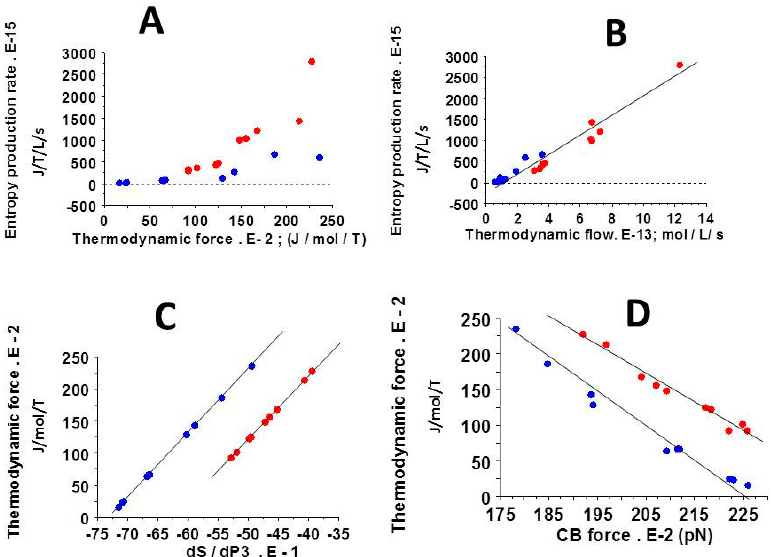
Figure 5. Parameters of statistical mechanics. ( A ): Non-linear relationship between the entropy production rate and the thermodynamic force. Influence of the thermodynamic force was moderately greater in COL-MSC-RDG (red) scaffolds than in COL-MSC scaffolds (blue); ( B ): Linear relationship between the entropy production rate and the thermodynamic flow; y = -212 + 216 * x; r =0.97. Influence of the thermodynamic flow was significantly greater in COL-MSC-RDG scaffolds than in COL-MSC scaffolds; ( C ): Linear relationships between the thermodynamic force and the statistical entropy derivative according to probability PD3 (dS/dPD3); y = 7.3 + x; r = 1 in COL-MSC scaffolds; y = 6.2 + x; r = 1 in COL-MSC-RDG scaffolds. ( D ): Linear relationship between the thermodynamic force and the CB force: y = 990 - 4.4 x; r = 0.99 in COL-MSC scaffolds and y = 900 - 3.7x; r = 0.87 in COL-MSC-RDG scaffolds. 4. Discussion 4.1. Applying Statistical Mechanics (SM) to Collagen Scaffolds SM together with the A. Huxley formalism allowed determining the microcanonical partition function (z) of the system [17]. The other macroscopic thermodynamic parameters of the system such as the statistical entropy, internal energy, grand potential, thermodynamic force, and the entropy production rate are byproducts of z and can be determined as well. All the thermodynamic information about a given system is contained in z which is related to the first and second laws of thermodynamics. It provides a clue of the average number of states that are thermally accessible at the temperature of the system under study [15]; z also reflects how molecular motors are partitioned over the available states. z was significantly increased in COL-MSC-RGD compared to COL-MSC scaffolds (Figure 2A) and was a hyperbolic function of PD3, which did not differ between the two types of scaffolds. The significant increase of the microcanonical partition function induced by the RGD accounted for the dramatic changes of the other thermodynamic quantities, i. e., E, S, thermodynamic force and entropy production rate (Figures 3 and 4). 4.2. Near-Equilibrium Thermodynamics Living systems never stay at equilibrium and either stand near equilibrium or far away from equilibrium [35]. Living systems can be maintained near equilibrium through a flow of energy and